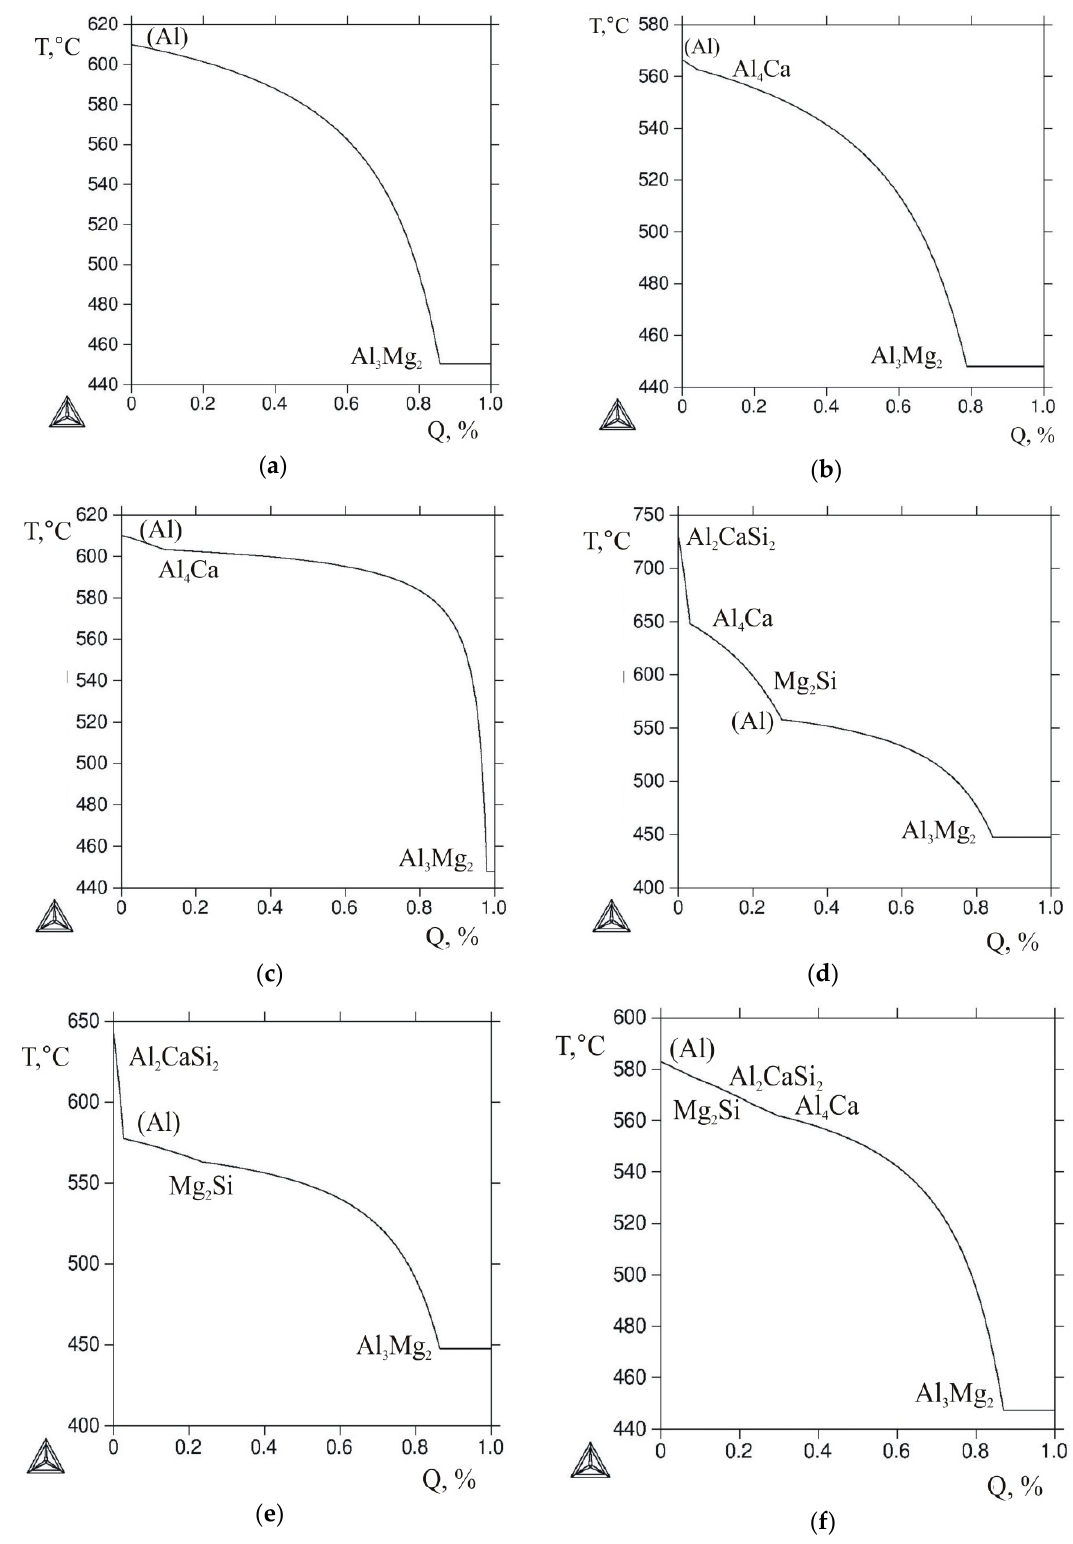
Figure 4. The calculated Q - T curves (Sheil–Gulliver simulation) for the alloys: ( a ) Al10Mg; ( b ) Al12Mg4; ( c ) Al2.5Mg6Ca; ( d ) Al10Mg10Ca2Si; ( e ) Al10Mg4Ca2Si; ( f ) Al10Mg3Ca1Si.